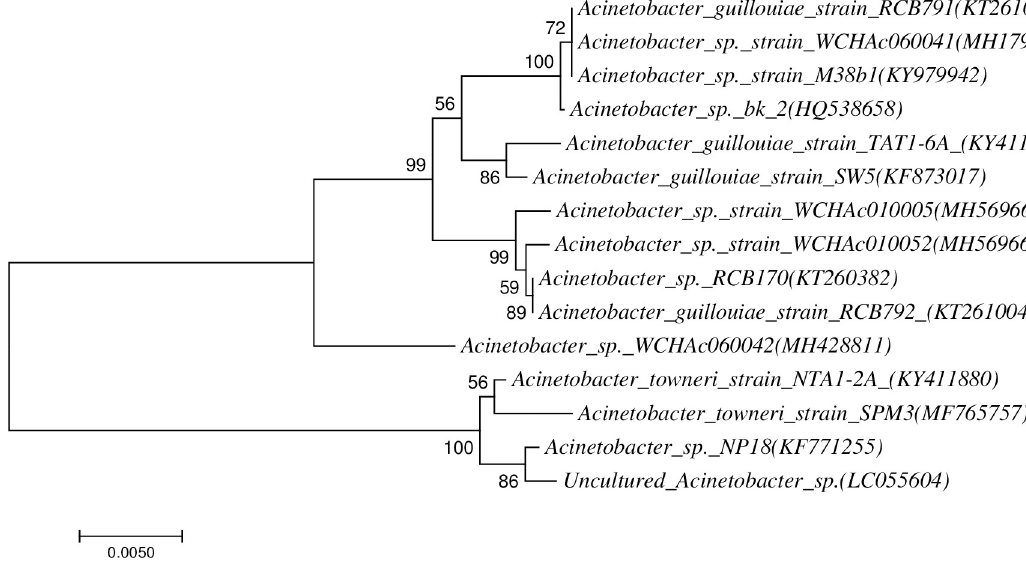
Fig 2. Neighbor joining tree of strains Acinetobacter towneri NTA1-2A and Acinetobacter guillouiae TAT1-6A.